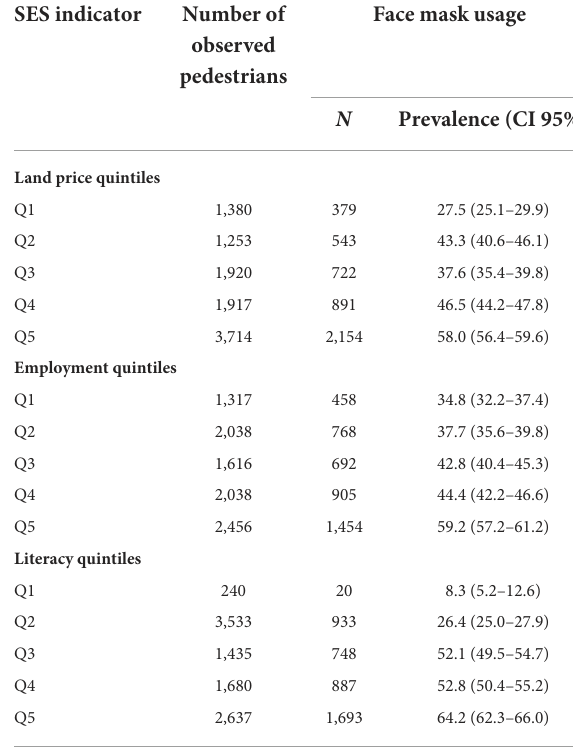
TABLE 2 Prevalence rates of face mask usage by socioeconomic